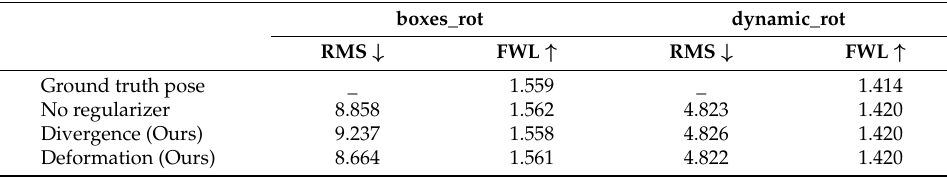
Table 3. Results on ECD dataset